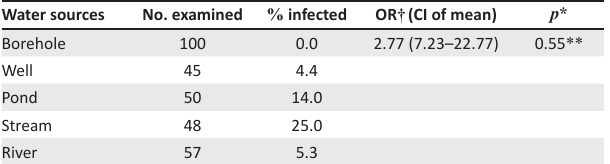
TABLE 3: Association between sources of water and Schistosoma haematobium infection ( n = 300), Nigeria, December 2016. Water